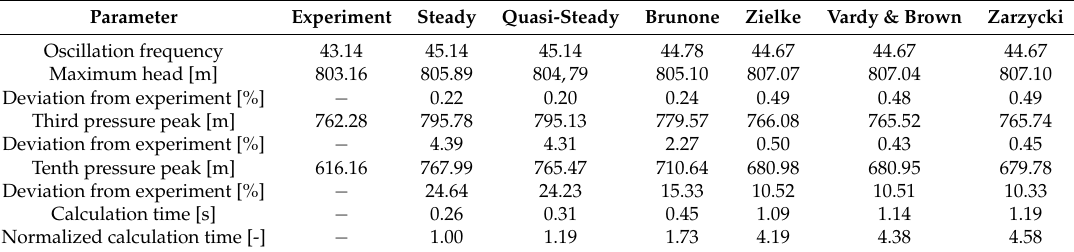
Table 2. Comparison of model and experimental results for experiment 1 conducted by [42]. The calculations were conducted on a laptop with an Intel R Clara, CA, USA) and 8 GB of random access memory